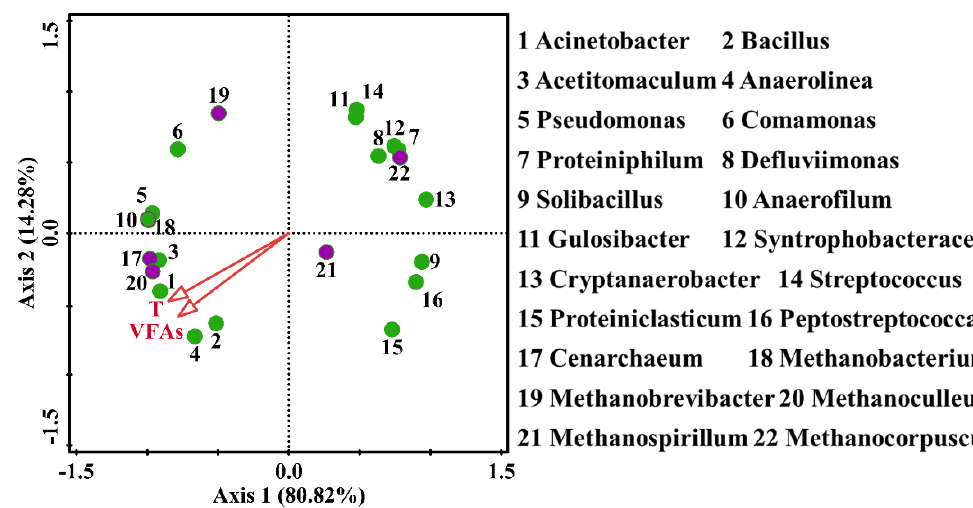
Figure 6. RDA on the correlation of system microbial composition with different environmental variables (temperature and VFAs).